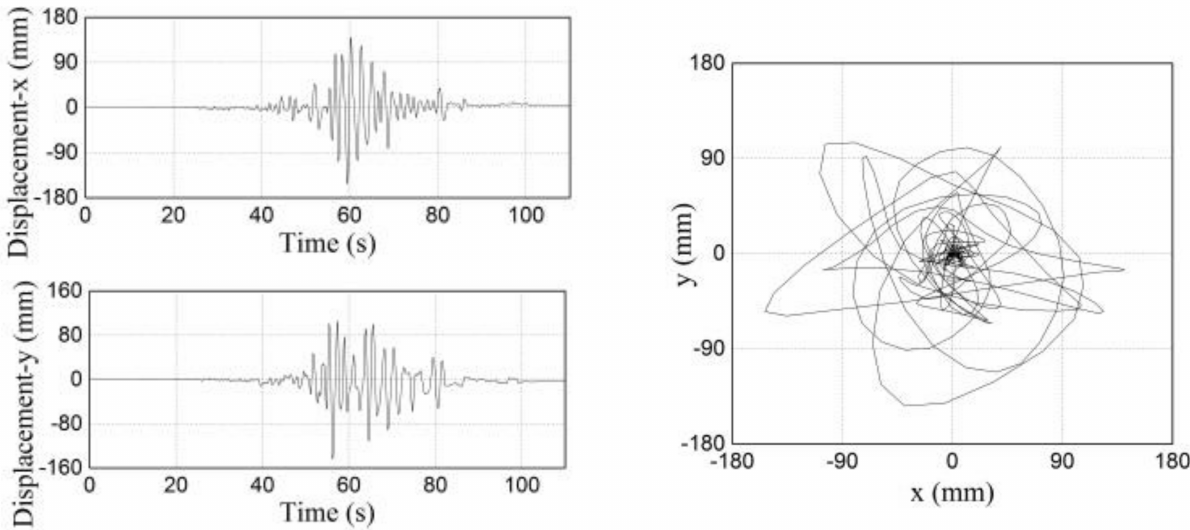
Figure 32. The relative displacements and movement locus of the b200d380 bearing subjected to 061CHC (low-frequency) ground motion when PGA = 2 m/s 2 .